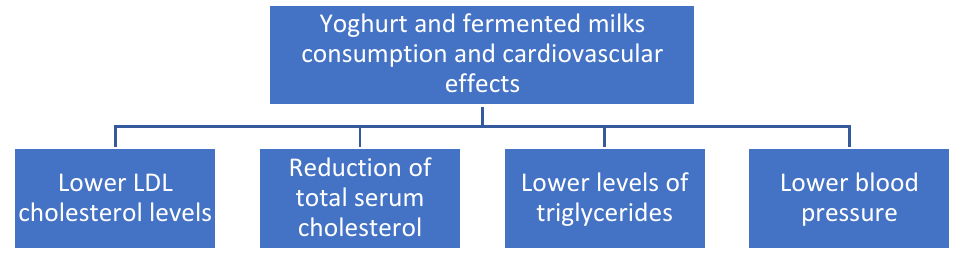
Figure 4. Cardiovascular effects of yoghurts and fermented milk consumption.